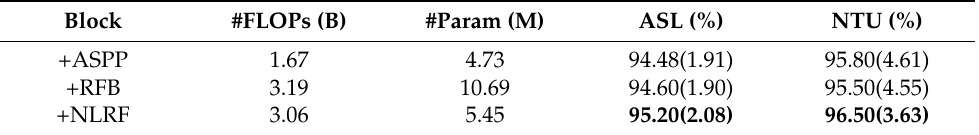
Table 1. Performance comparison of RFaNet with different blocks of receptive fields, evaluated on the ASL and NTU datasets. We simply replaced the NLRF block with ASPP and RFB to evaluate the effects of these blocks. Numbers in parentheses indicate the standard deviation. #FLOPs: number of floating-point operations; #Param: number of parameters in the model. The symbol + indicates that the block was inserted into the proposed RFaNet. Bold values indicate the highest classification accuracy among the three blocks.